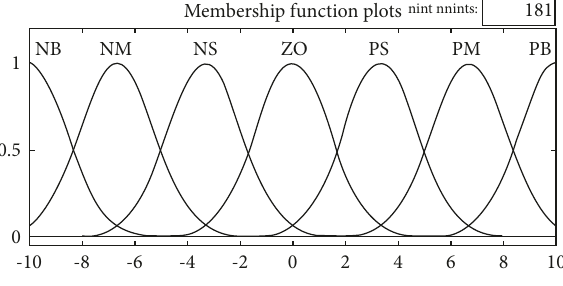
Figure 7: Input Δ ω membership function.